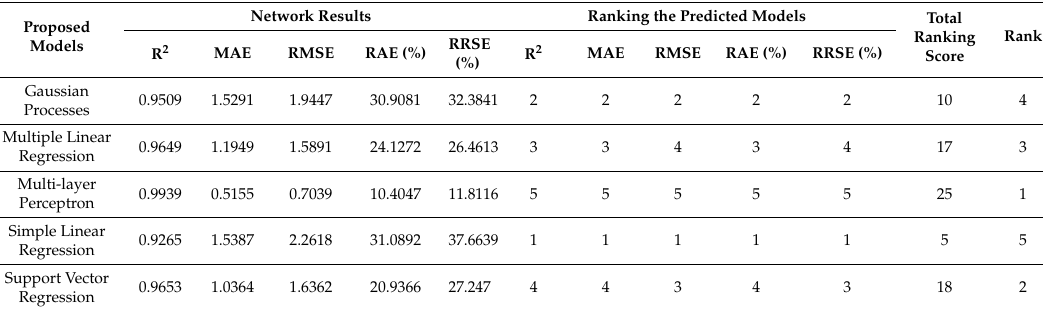
Table 2. Total ranking of the testing dataset in predicting the factor of